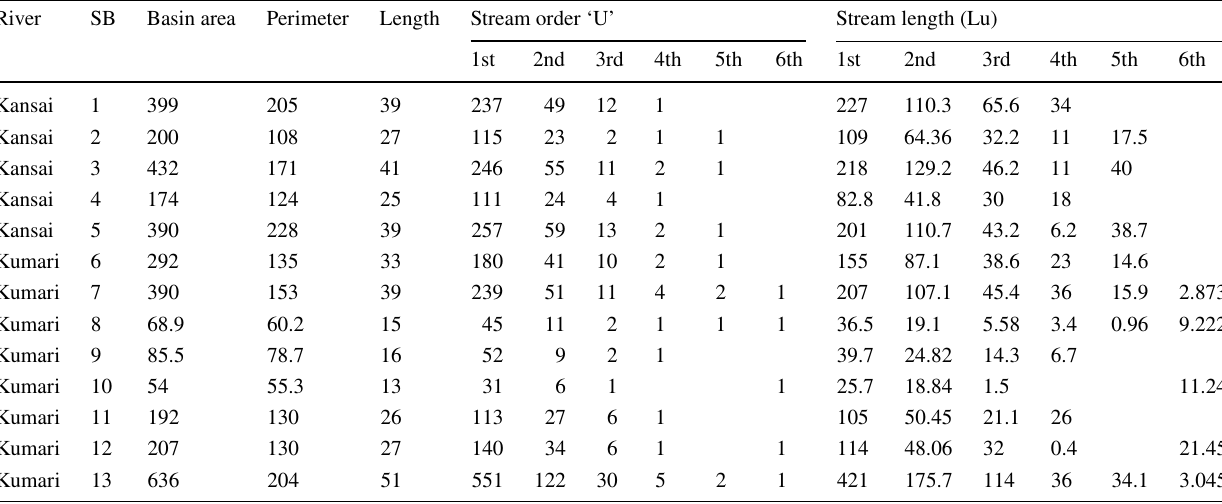
Table 3 Computed linear parameters of 13 sub-basins in Kansai–Kumari inter-fluvial site River